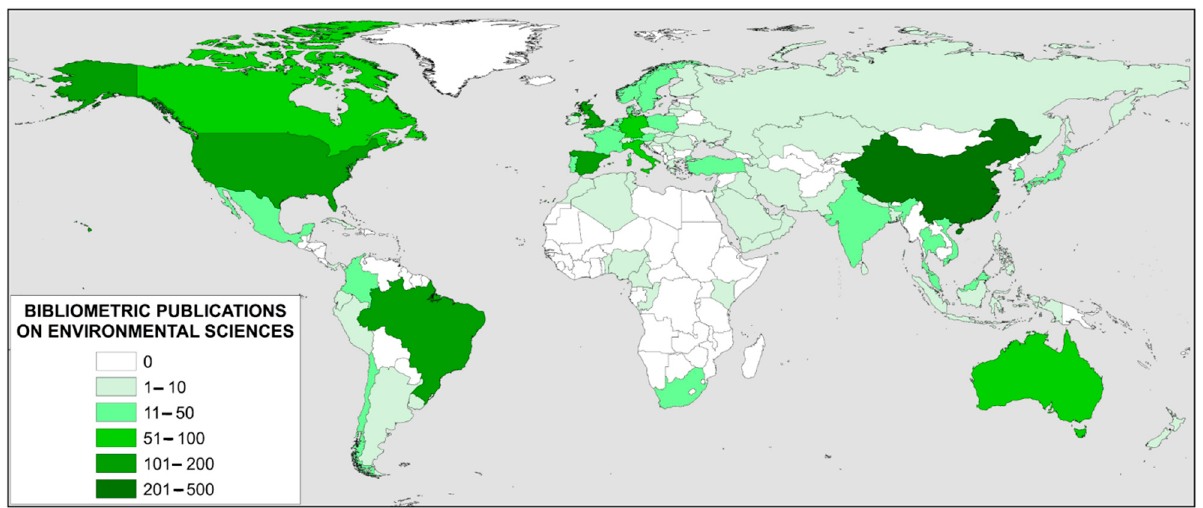
Figure 8. Global distribution of bibliometric publications by country in the environmental sciences category.